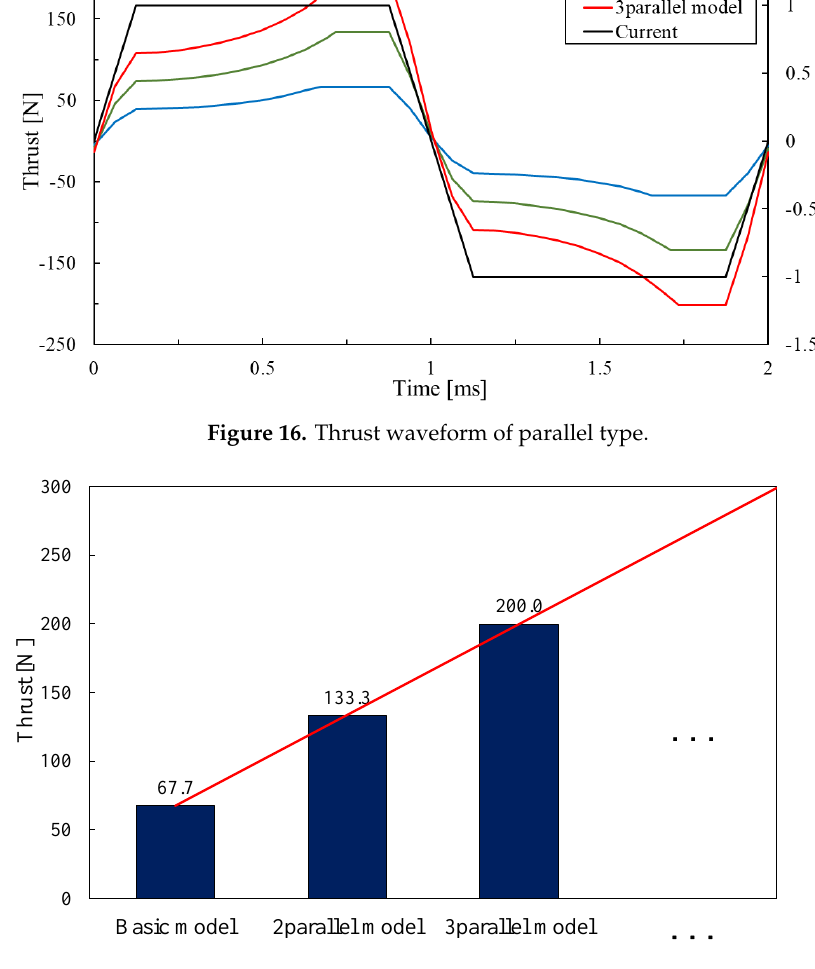
Figure 17. Maximal thrust of parallel